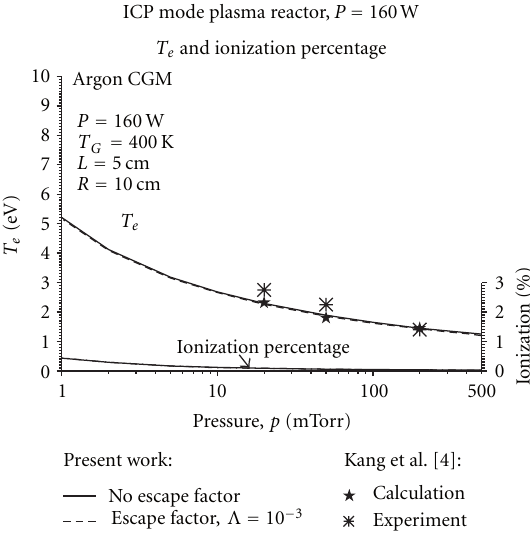
Figure 8: Calculated T e and ionization percentage in the plasma reactor for 1mTorr < p < 500mTorr. Ionization percentage is to be read in the right side scale.